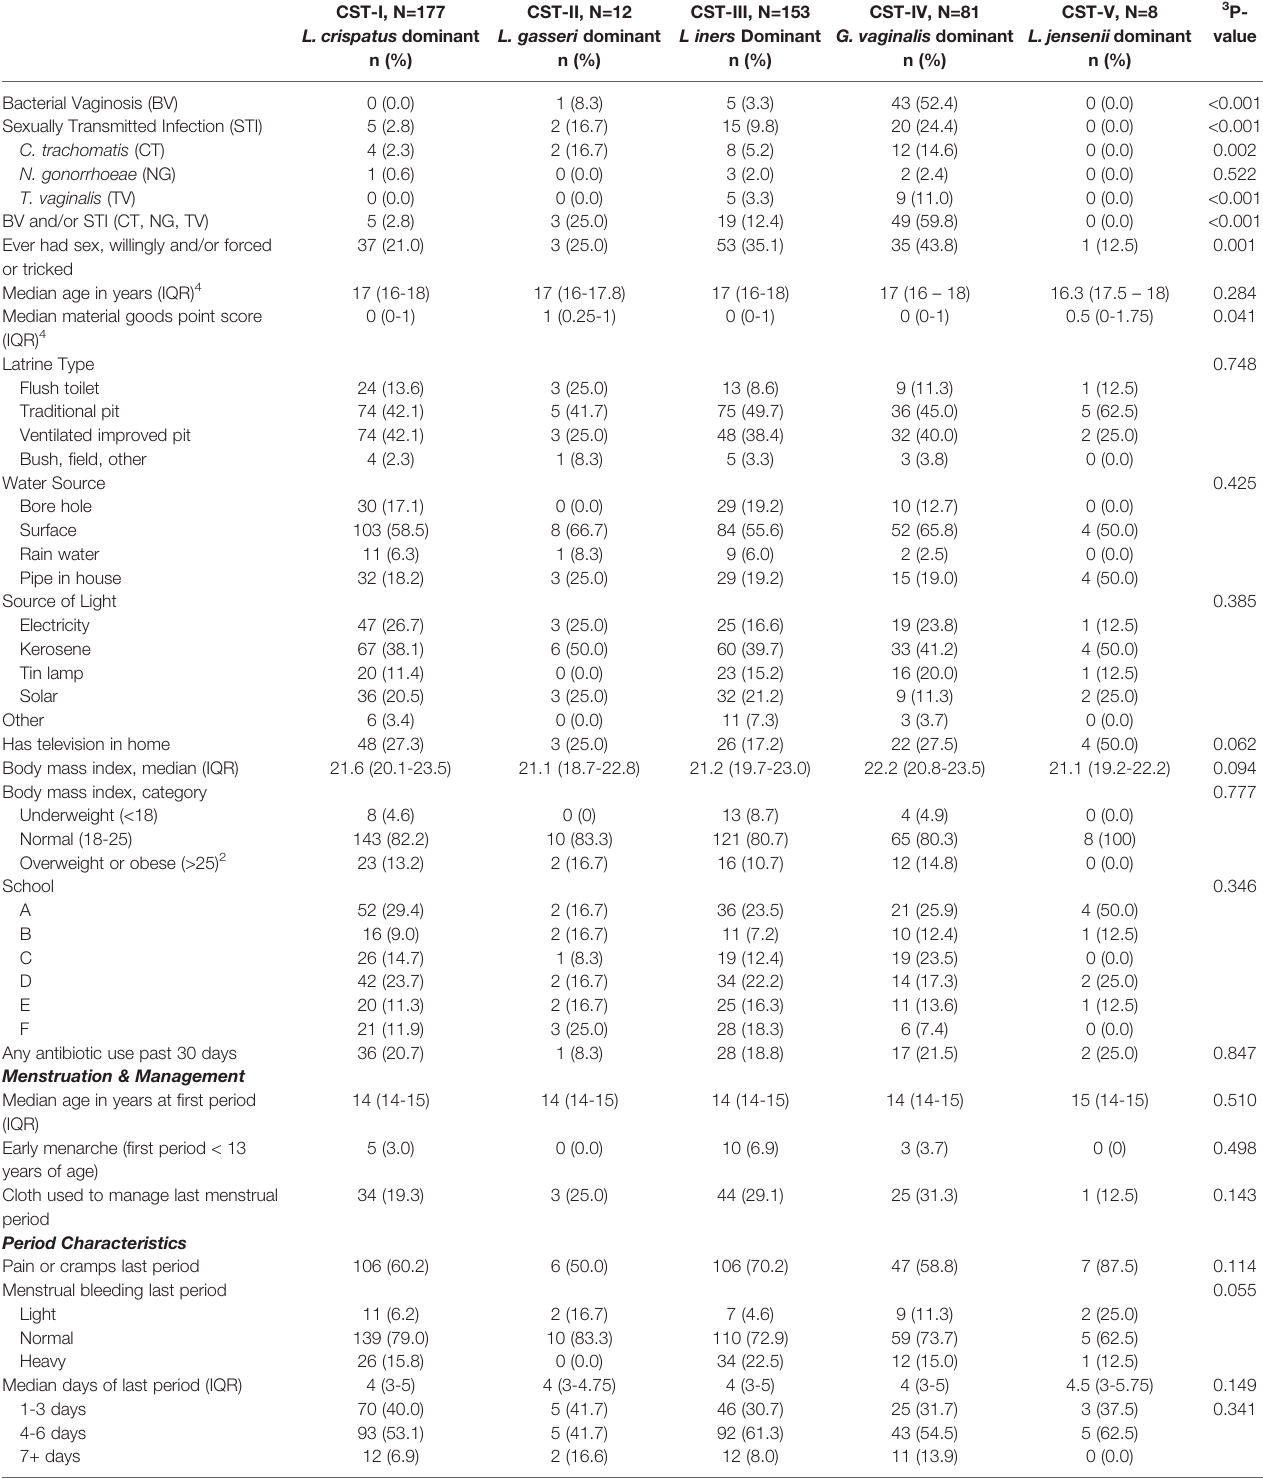
TABLE 2 | Distribution of characteristics by vaginal microbiome community state type 1 . CST-I, N=177 L. crispatus dominant